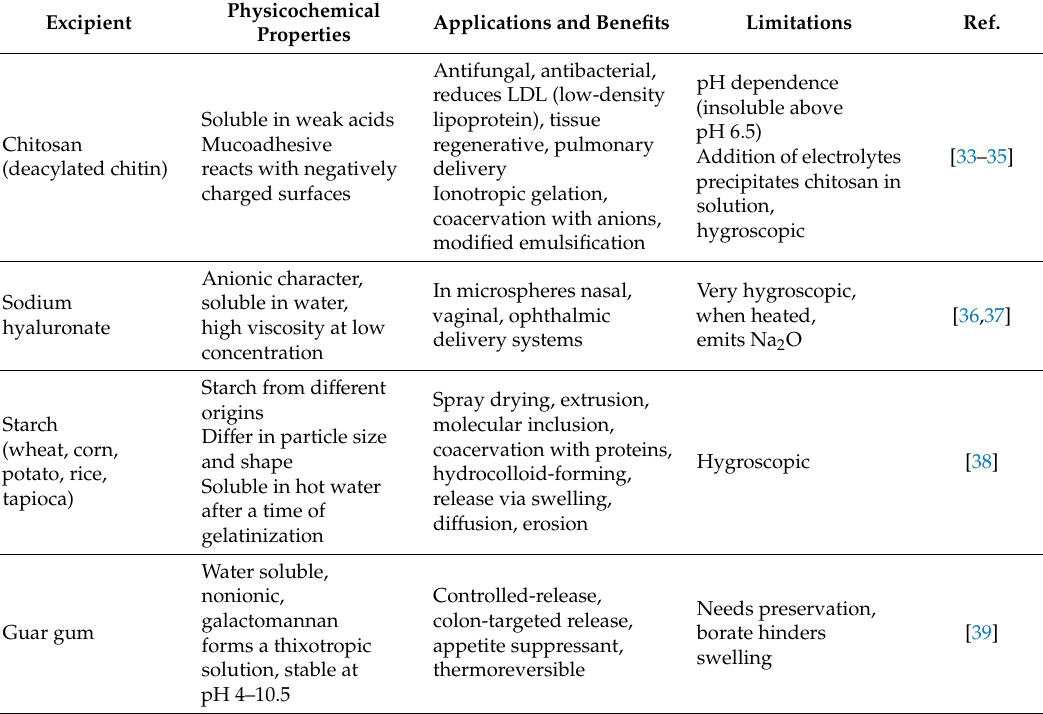
Table 2. Examples of polysaccharides of various origin used in